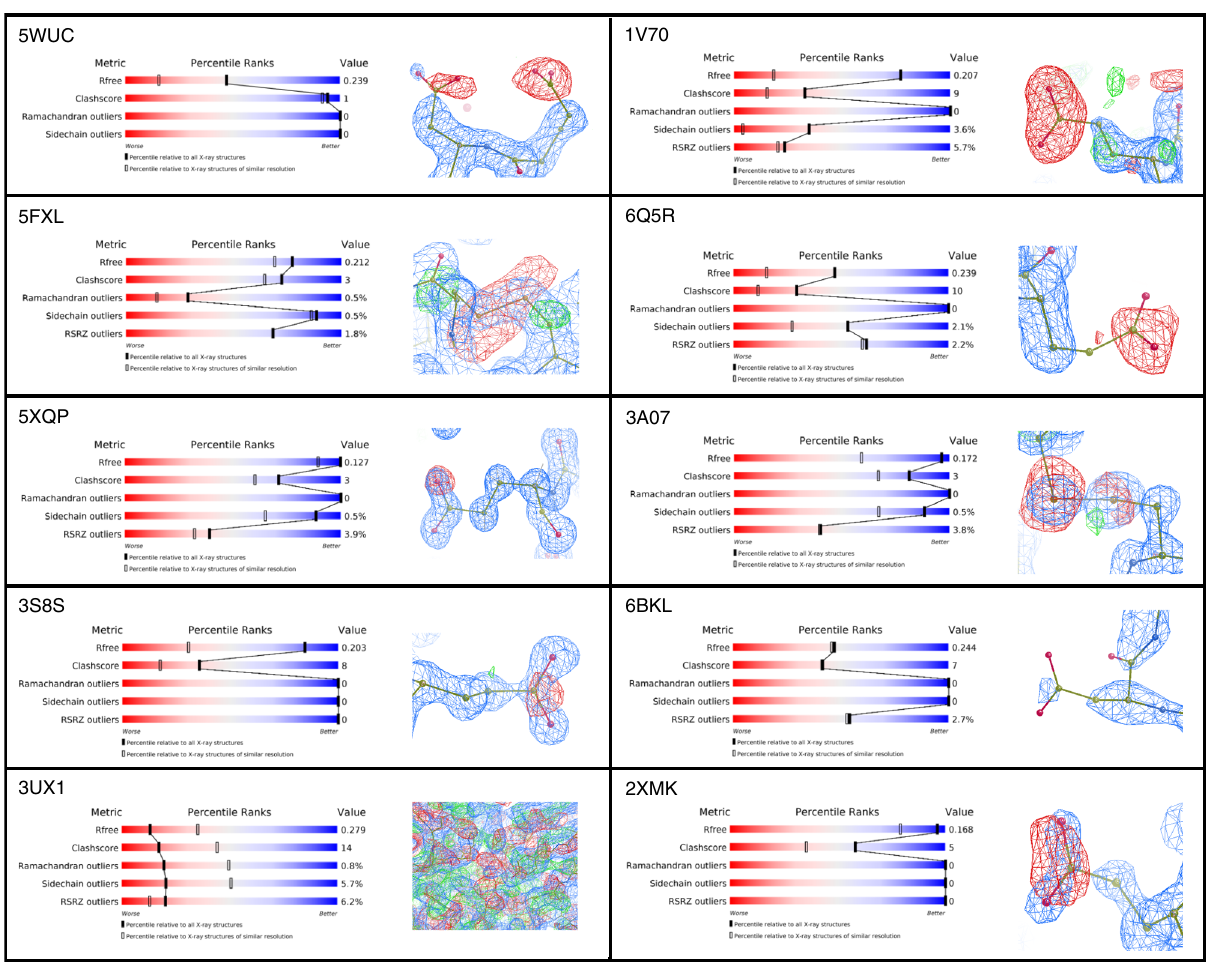
Fig. 6 Observation of typical radiation damage features in structures with high B net values. wwPDB validation statistics, models and density maps for the ten structures with the highest B net values in the PDB-REDO databank. For the eight structures with visible radiation damage artefacts in their associated electron density difference maps, a representative example is shown: for the two structures without such artefacts, the alternative causes of their high B net and B net -percentile values are shown instead. 2m F obs – D F calc maps (blue) are contoured at 1.5 rmsd; F obs – F calc difference density maps are contoured at ± 3.0 rmsd